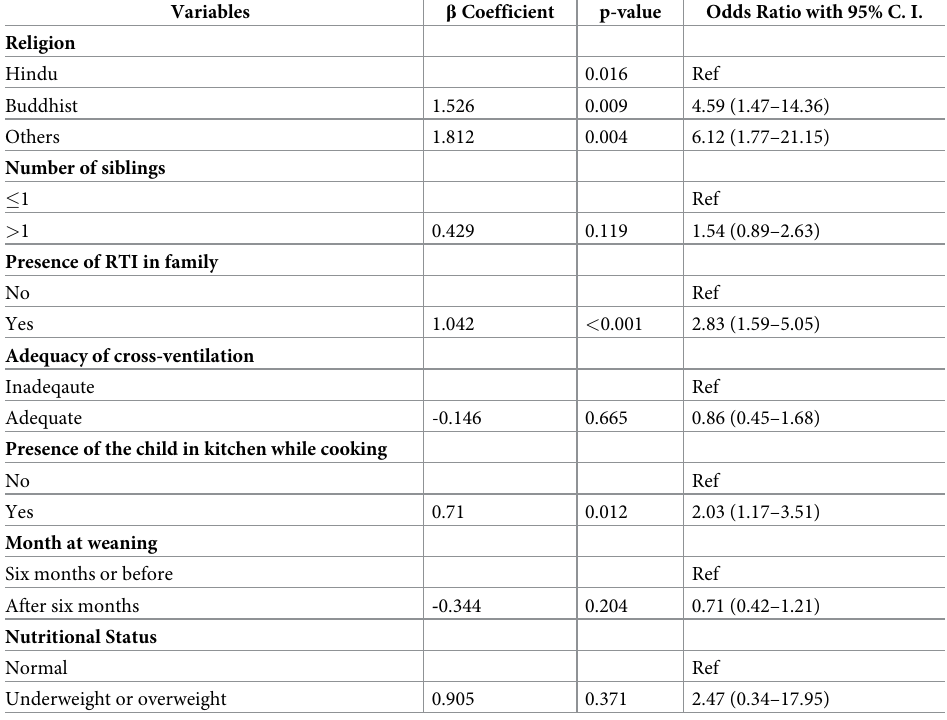
Table 3. Multivariate analysis of the factors associated with ARI. n =